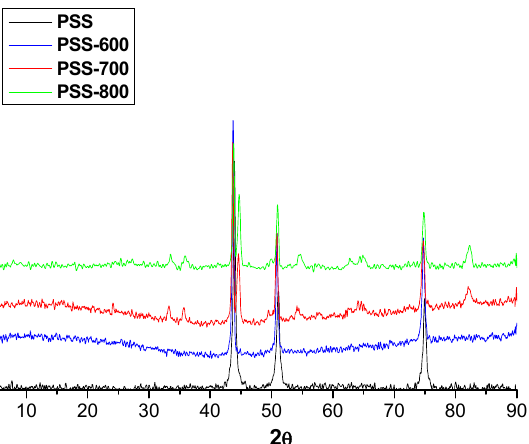
Figure 3. XRD patterns of bare PSS and PSS substrates after oxidation at 600, 700 and 800 °C, respectively.